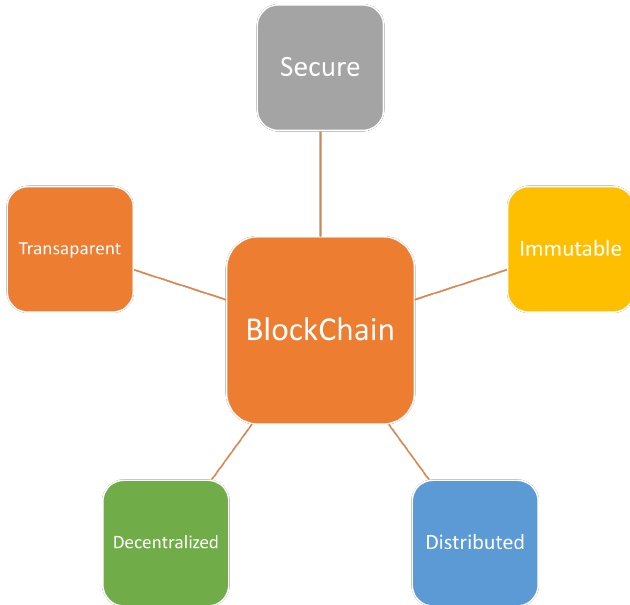
Figure 1. Characteristics of a blockchain